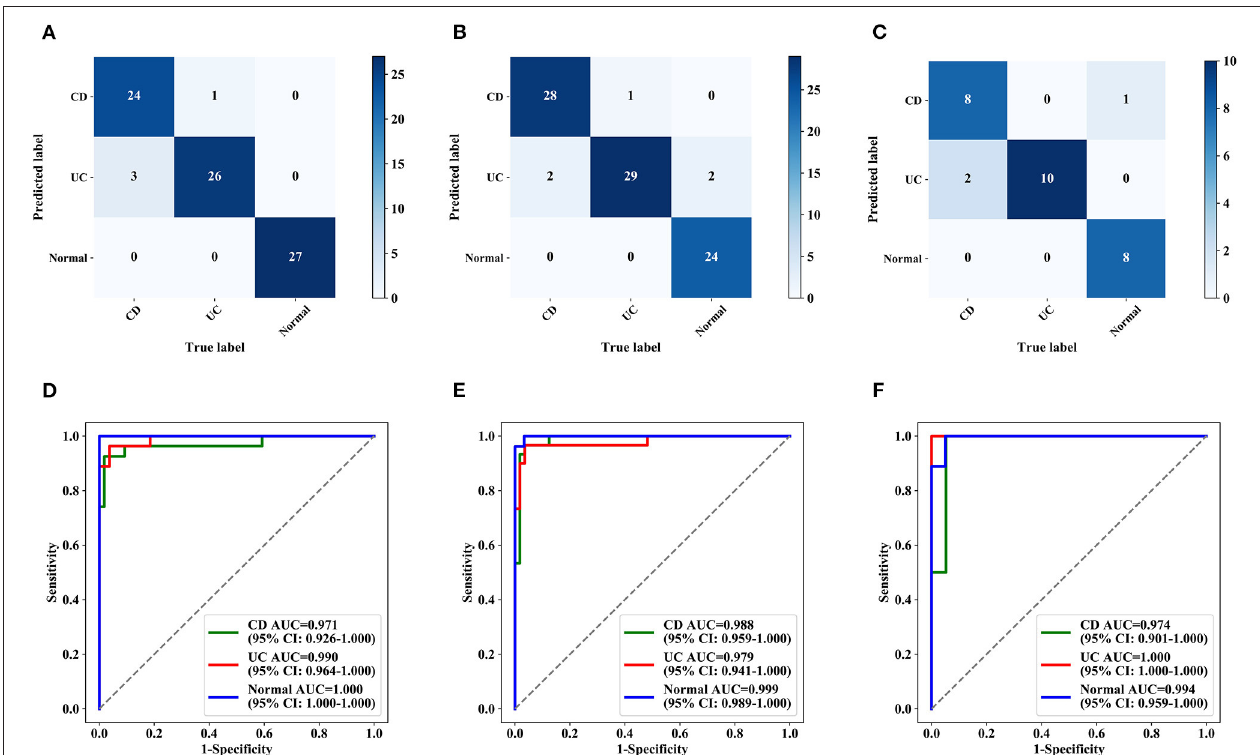
FIGURE 5 | Confusion matrix and ROC curves for multicentre validation (per patient). Confusion matrix (A–C) and ROC curves (D–F) for three hospitals. (A,D) The First Affiliated Hospital of Chongqing Medical University. (B,E) The Sixth Affiliated Hospital of Sun Yat-sen University. (C,F) Tongji Hospital Affiliated with Huazhong University of Science and Technology. AUC, the area under the receiver operating characteristic curve; ROC, receiver operating